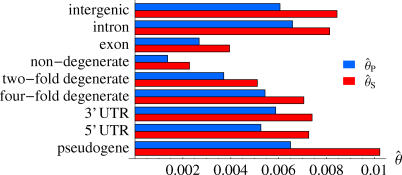
Levels of Polymorphism for Different Classes of SitesLevels of polymorphism were quantified using two different estimators of the neutral mutation rate θ: θ^S
, which uses the number of polymorphic sites, and θ^P
, which uses the average number of pairwise differences [3].